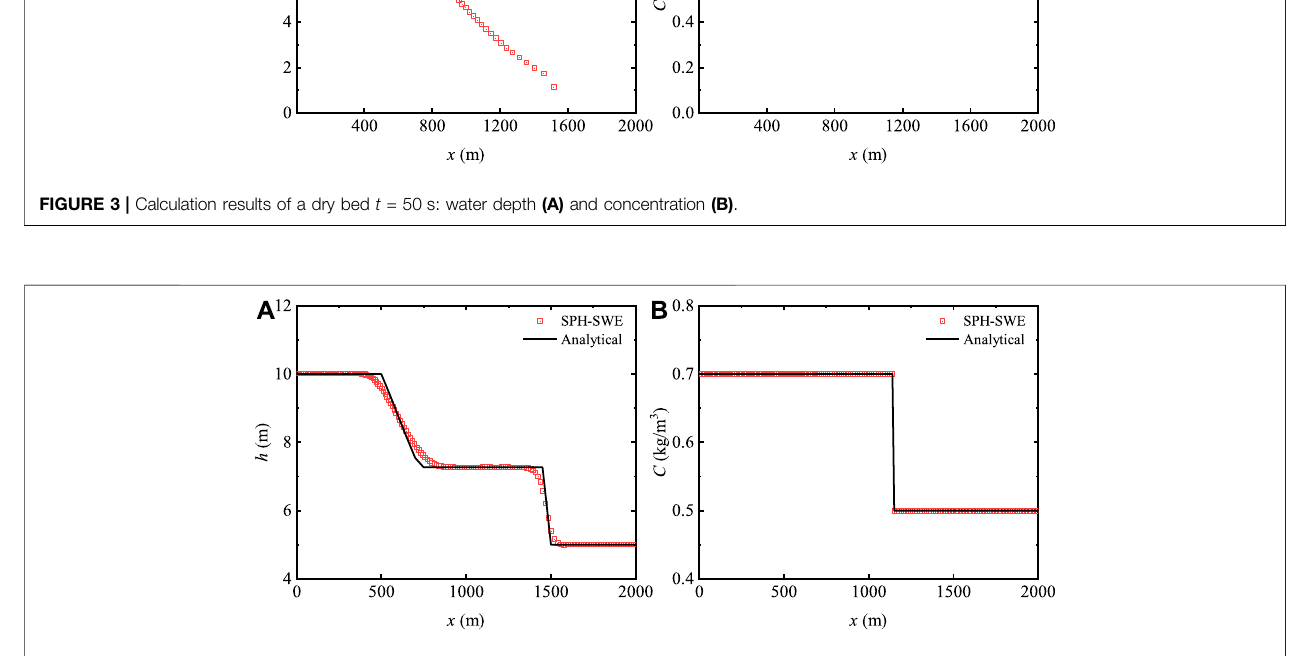
FIGURE 4 | Calculation results of a wet bed t = 50 s: water depth (A) and concentration (B) .